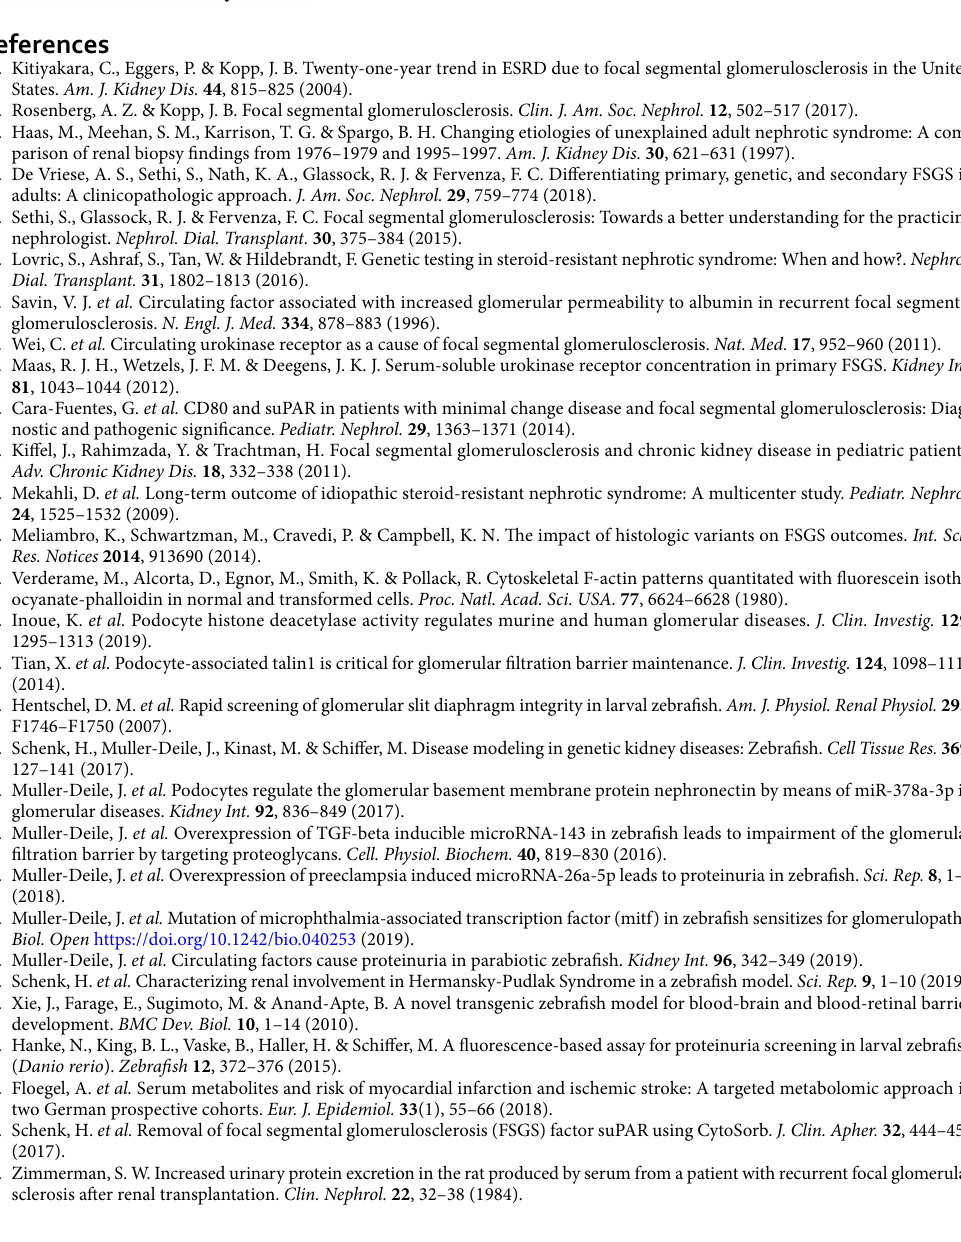
Tris pH 7.4: Pax8, a rabbit polyclonal antibody against paired box gene 8 (Cell Marque, Rocklin, CA, USA) 1:50; synaptopodin, a mouse monoclonal antibody against rat synaptopodin (clone G1D4, Progen Biotechnik GmbH, Heidelberg, Germany) 1:100. Double-staining of Pax8 with podocyte marker synaptopodin was performed using fluorescence labelled secondary antibodies diluted 1:200 in 50 mM Tris pH 7.4 and incubated for 30 min at room temperature. The following secondary antibodies were used: donkey anti-mouse IgG Alexa Fluor 647 (A31571) and donkey anti-rabbit IgG Alexa Fluor 568 (A10042) both from Thermo Fisher Scientific (Waltham, MA, USA). Nuclei of cells were stained with DAPI in distilled water (0.2 µg/ml) for 5 min followed by rinsing in Tris buffer. Finally, sections were covered with TrueView mounting kit (Vector laboratories) and analyzed using laser scanning confocal microscopy (LSM Zeiss 710 and Zen software, Zeiss GmbH, Jena, Germany) and Image- J software. Negative controls for immunostaining included either deletion or substitution of the primary